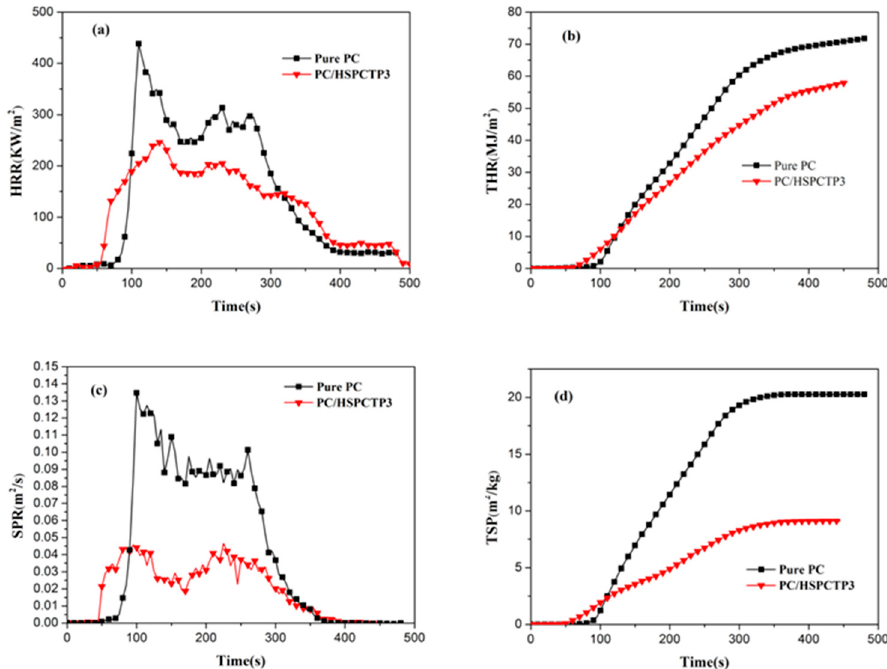
Figure 5. Heart release rate (HRR) ( a ), total heat release (THR) ( b ), smoke produce rate (SPR) ( c ) and total smoke production (TSP) ( d ) curves of pure PC and PC/HSPCTP3 composites.